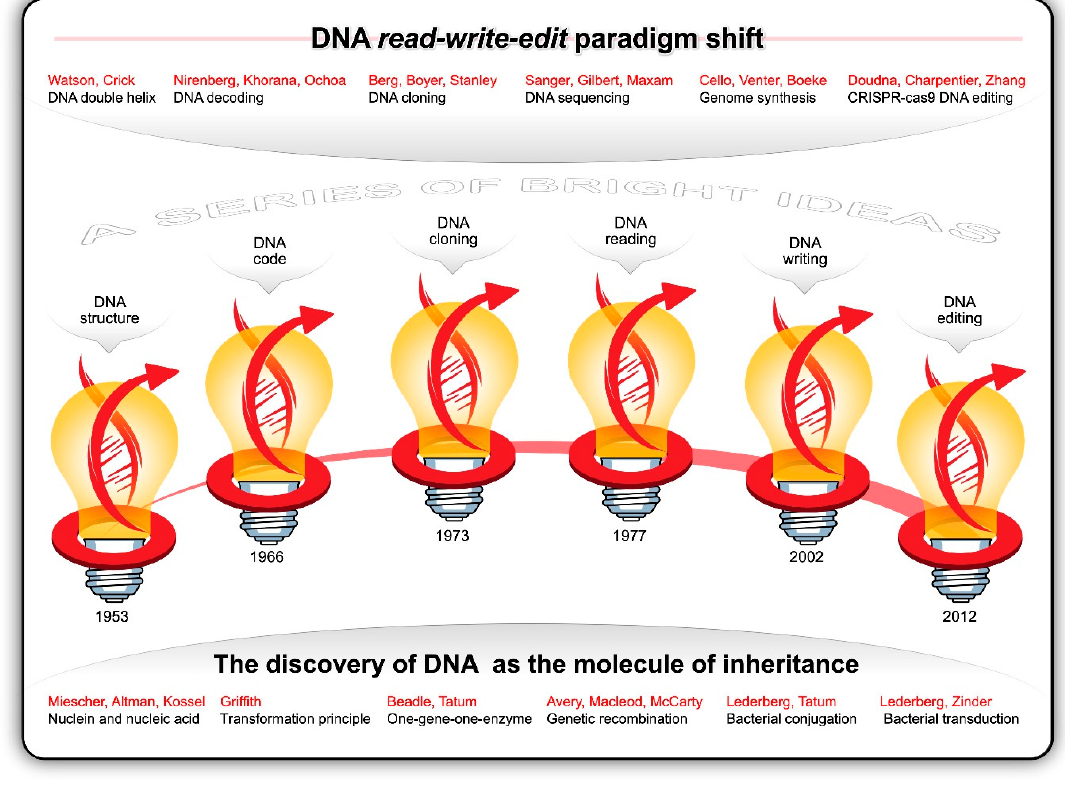
Figure 3. The discovery of DNA is one of our greatest scientific achievements. The history of DNA science consists of a series of bright ideas and profound breakthroughs that led to the current read-write-edit paradigm shift.